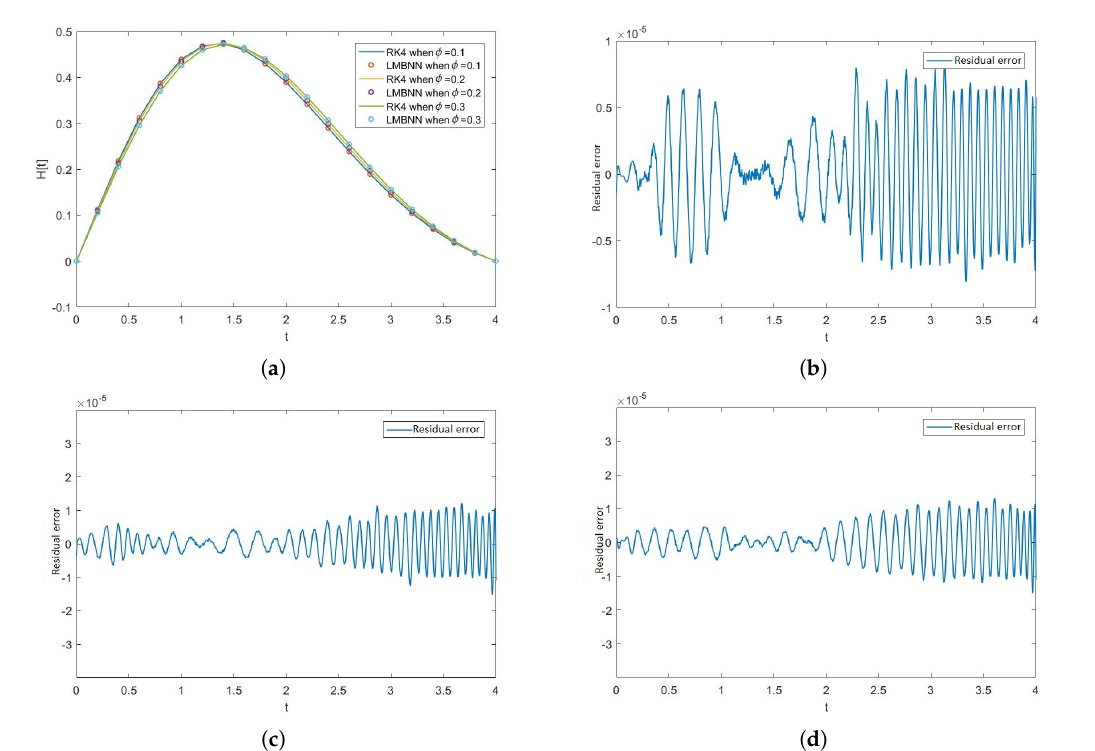
Figure 13. Effects of volume fraction φ on H and residual error graphs in the variance of φ . ( a ) Nu- merical outputs of H through RK4 and LMBNN for different values of φ . ( b ) Error in H when φ = 0.1. ( c ) Error in H when φ = 0.2. ( d ) Error in H when φ =